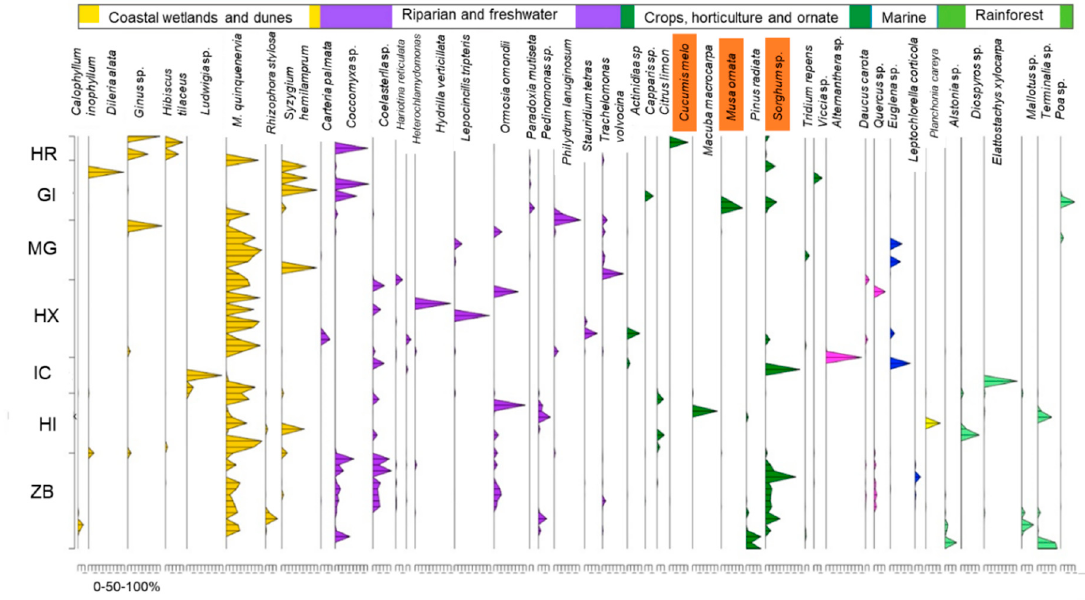
Figure 3. Relative abundance ( x -axis, % of total) of Operational Taxonomic Unit (OTU) of surface soils of seven tropical forested floodplain wetlands ( y -axis). The tree species Melaleuca quinquenervia was the most abundant OTU. Key species associated with agricultural activities within the catchment are highlighted: melons ( Cucumis melo ), banana ( Musa ornata ), and Sorghum sp. Only species with a minimum total DNA abundance of 10% are included. The full names and location of the sampling sites can be found at Table 1 and Figure 1.